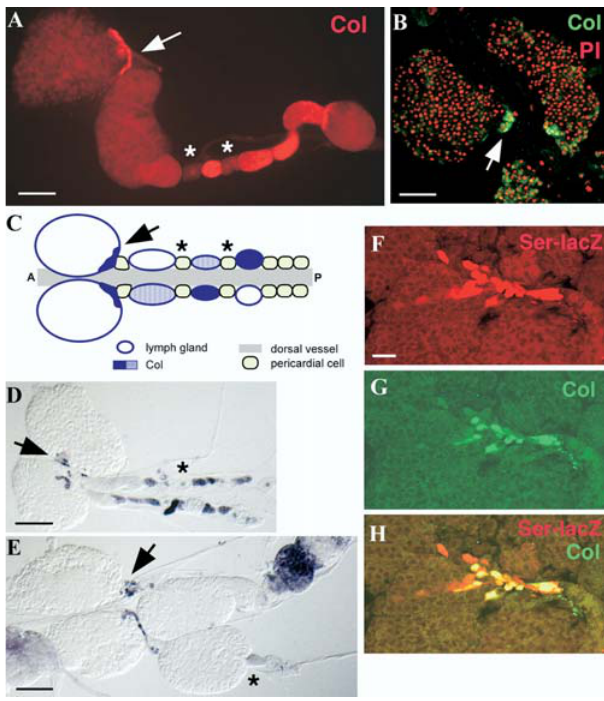
Figure 3. Col Expression in Lymph Glands of Third Instar Larvae (A and B) Col is expressed in the primary lobes, in a posterior cluster of cells (arrow), and in a variable number of secondary lobes. Low expression is also detected in some pericardial cells (asterisks), the significance of which remains unknown. PI, propidium iodide. (C) Schematic representation of the lymph glands and Col expression in late third instar larvae. (D and E) Col expression 24 h (D) and 48 h (E) after wasp infection; despite strong cell proliferation, including in secondary lobes, Col expression remains unchanged (black arrow). (F–H) Overlap between Ser-lacZ (Bachmann and Knust 1998) and Col expression in PSC cells; note a few scattered Ser-expressing cells that do not stain for Col. Bars: 50 l m (A, B, D, and E) ; 10 l m (F–H). DOI: 10.1371/journal.pbio.0020196.g003